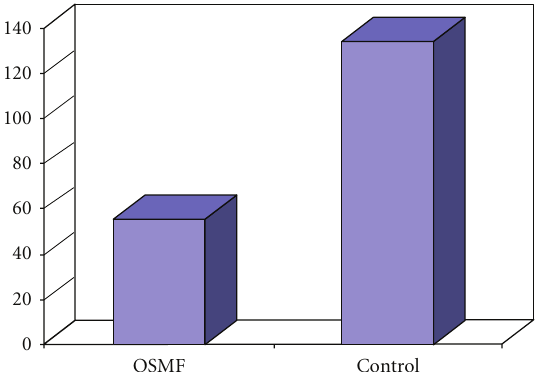
Figure 5: Mean hemoglobin (%) level in OSMF stage I, OSMF stage II and control groups.